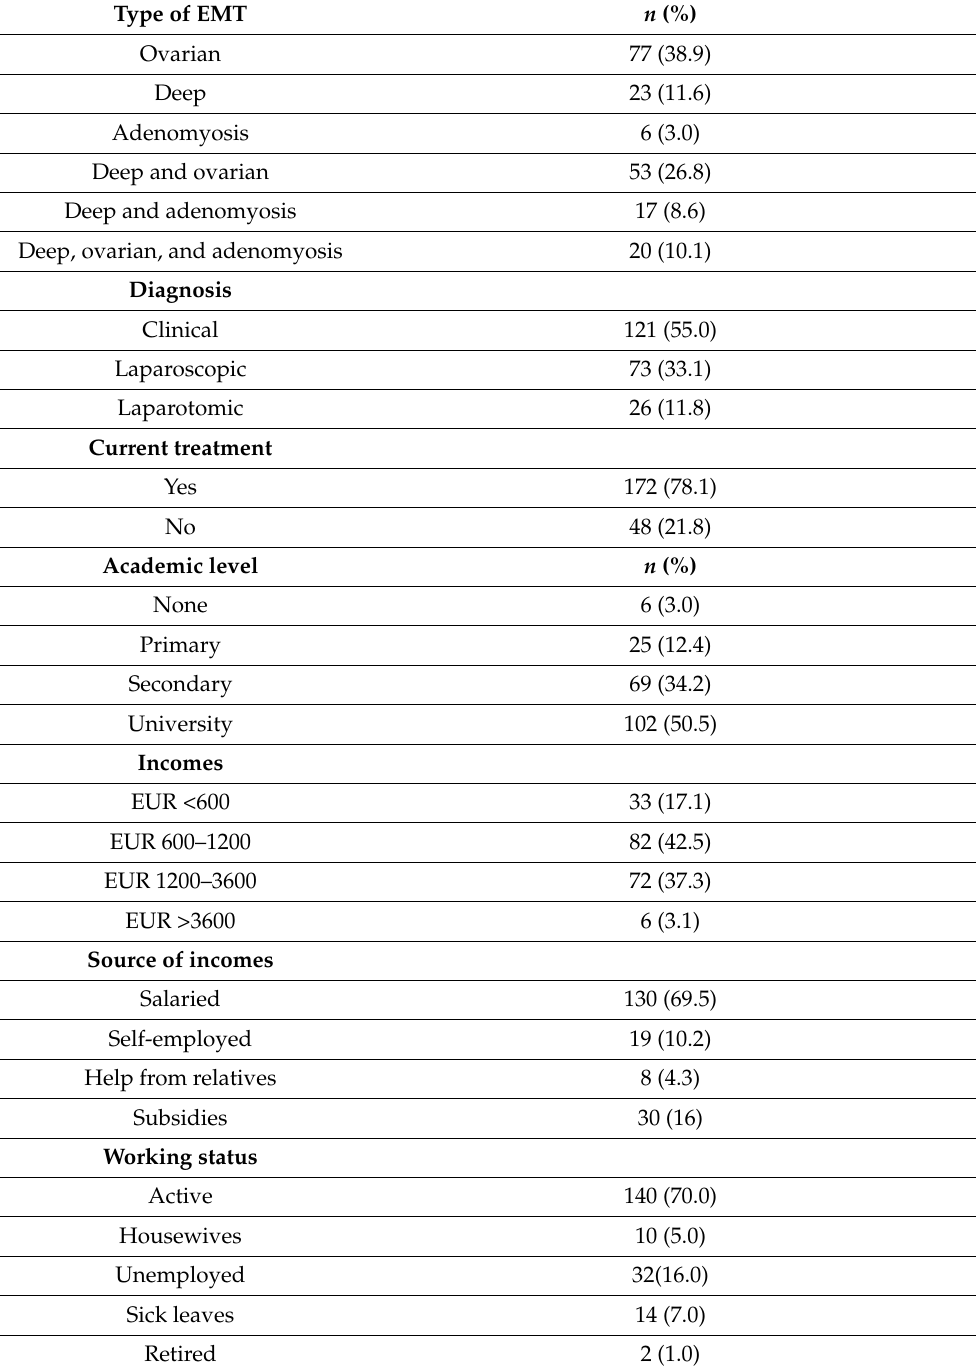
Table 1. Sociodemographic and clinical features of the